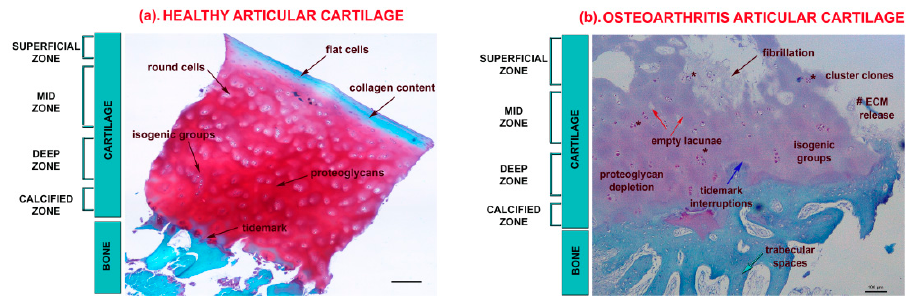
Figure 1. Representative micrographs of articular cartilage tissues representing healthy ( a ) and OA ( b ) stained with Safranin-O / Fast Green staining taken from the laboratory archive. Representation of typical healthy and OA features in the superficial, mid, deep, and calcified zones of articular cartilage. Scale bar: 100 µ m; red staining: proteoglycan content; pinkish staining: depletion of proteoglycan content; green staining: collagen content. ( a ) Healthy articular cartilage, black arrows report: (i) the presence of flat cells in the ECM rich of collagen fibres in the superficial zone; (ii) the presence of round cells in the ECM rich of proteoglycans in the mid-zone; (iii) the presence of isogenic groups in the ECM rich of proteoglycans in the deep zone; and (iv) the presence of tidemark in the calcified zone. ( b ) OA articular cartilage, black arrow reports the presence of fibrillation in the superficial zone; red arrows report the presence of empty lacunae; blue arrow: tidemark interruptions; green arrow: trabecular spaces; # reports ECM release; * cluster clones.